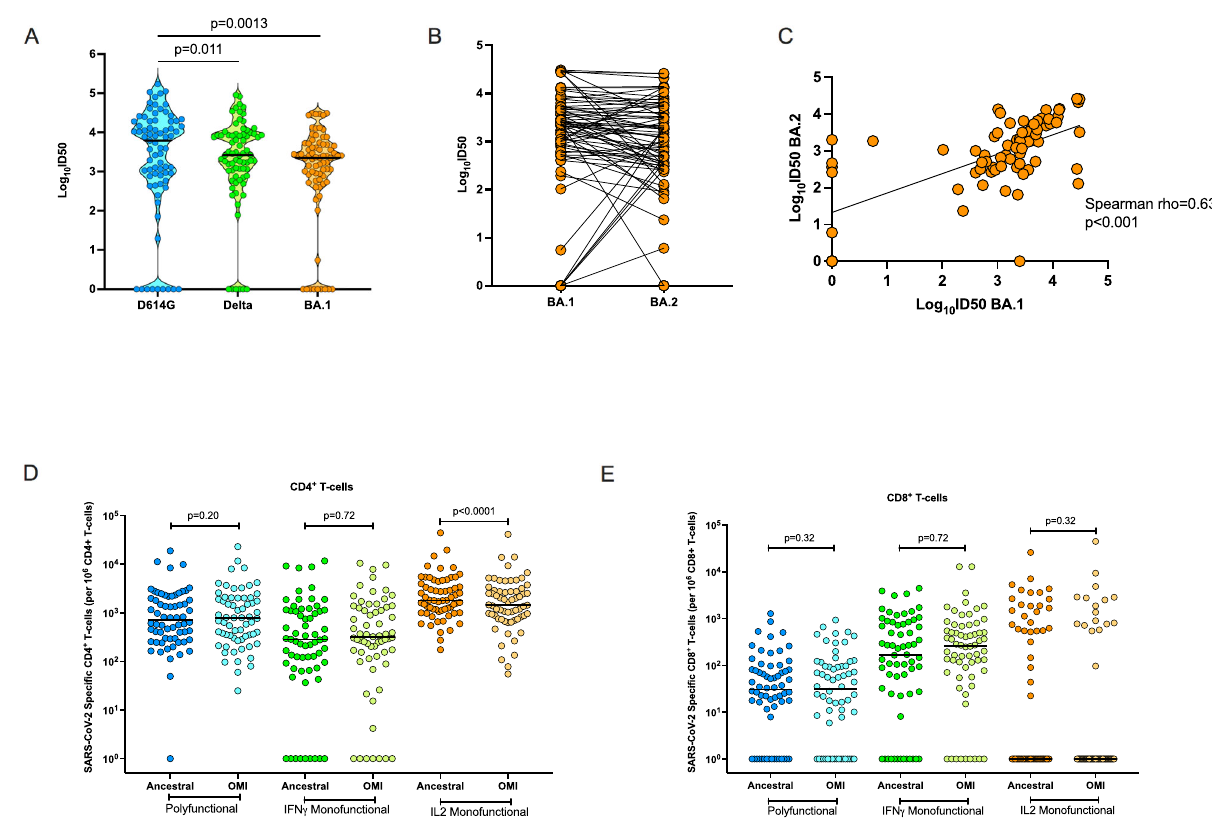
Fig. 3 | Immune response against ancestral SARS-CoV-2, Delta, and Omicron BA.1 in transplant recipients with Omicron-BA.1 infection. A Violin dot plots of the 50% neutralization titers (log 10 ID50) of neutralizing antibodies against D614G, Delta, and Omicron BA.1, in transplant recipients post-BA.1 infection ( n =75). Each circle represents an individual patient antibody titer. Horizontal lines represent median values. The p value of the difference was estimated using a two-sided Wilcoxon matched-pairs signed-rank test. B Paired BA.1 and BA.2 directed neu- tralizing responses in all patients from the same cohort ( n =75). C Scatter plot showing two-tailed Spearman correlation between the log 10 ID50 of neutralizing